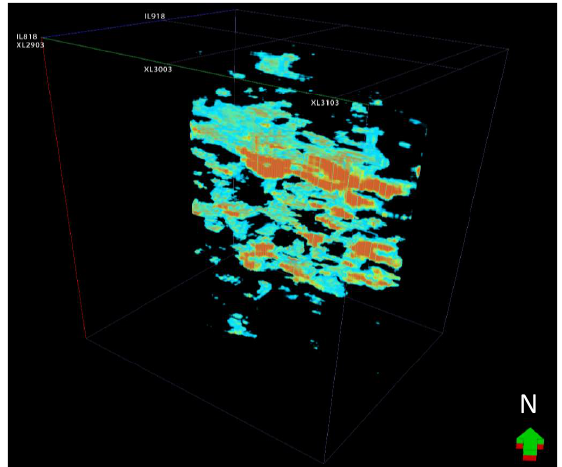
Figure 8. Three dimensional visualization of a strike-slip fault damage zone by the steerable pyramid attribute in the study area.